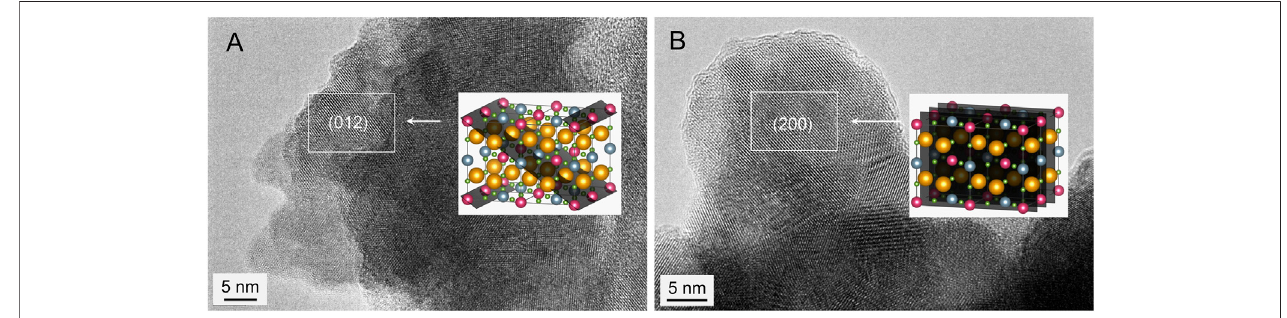
FIGURE 6 | HRTEM images of (A) the partly synthesized Sr 2 FeMoO 6 and (B) the completely synthesized Sr 2 FeMoO 6 . The lattice fringes correspond to the crystallographic planes (A) (012) with interplanar distance d (012) = 0.36 nm and (B) (200) with d (200) = 0.28 nm of the Sr 2 FeMoO 6 phase (ICDD PDF 70-8133).